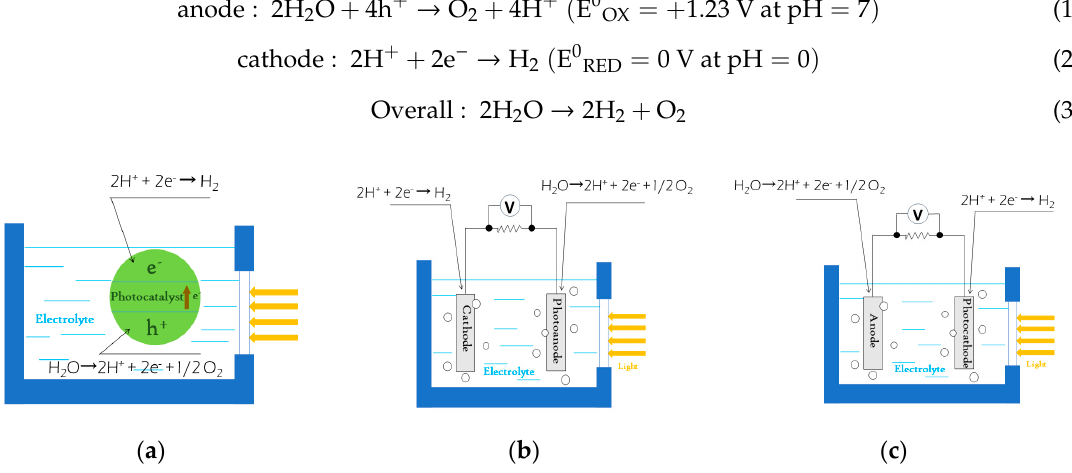
Figure 4. Schematic diagram of photocatalytic hydrogen production principle of photocatalyst Figure4. Schematicdiagramofphotocatalytichydrogenproductionprincipleofphotocatalystdispersed dispersed in electrolyte ( a ), schematic diagram of hydrogen production principle in a in electrolyte ( a ), schematic diagram of hydrogen production principle in a photoelectrocatalytic system photoelectrocatalytic system composed of a n-type semiconductor as photoanode ( b ), and a p-type composed of a n-type semiconductor as photoanode ( b ), and a p-type semiconductor as photocathode semiconductor as photocathode ( c ), respectively. ( c ),